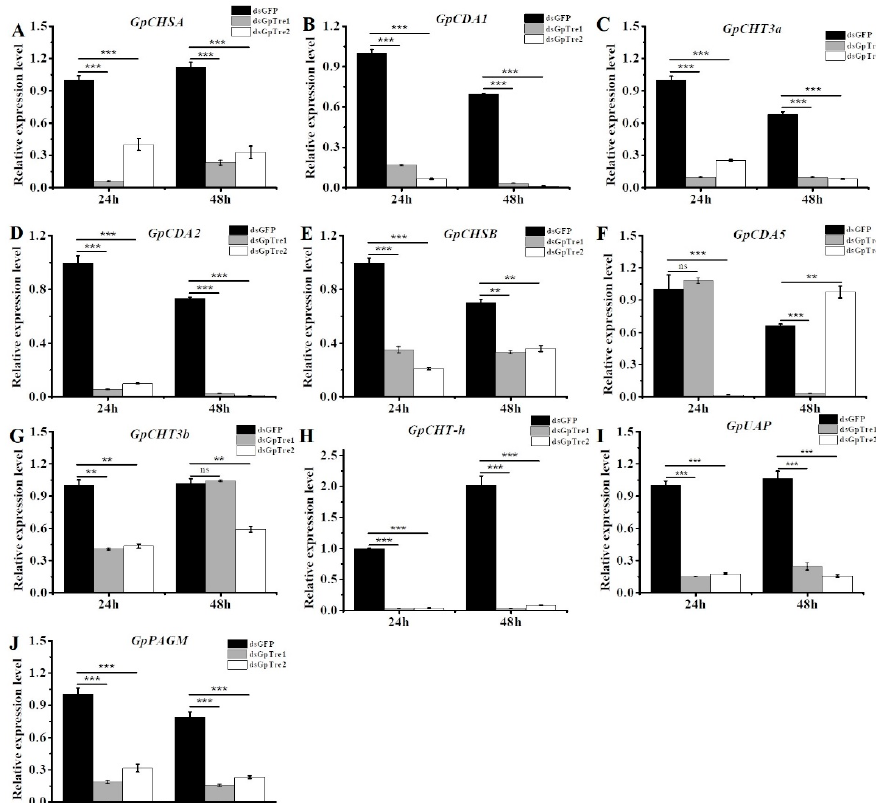
Figure 6. Analysis of the expression levels of key genes involved in the chitin metabolism pathway after knockdown of GpTre1 and GpTre2 . The expression levels were detected 24 h and 48 h after RNAi of GpTre1 and GpTre2 by RT-qPCR. ( A – D ) Expressions of 4 genes related to the integument pathway, ( E – H ) expressions of 4 genes related to the midgut pathway, ( I , J ) and the expressions of 2 key genes involved in chitin metabolism. dsGFP was used as the negative control. Data are showed as mean ± SE of three biological replicates. Differences between each dsRNA and dsGFP group within each time point was compared using non-parametric Kruskal–Wallis test followed by Dunnett’s post-hoc test. Asterisks above the bars indicated significant differences (** p < 0.01; *** p < 0.001; ns, no significance difference).